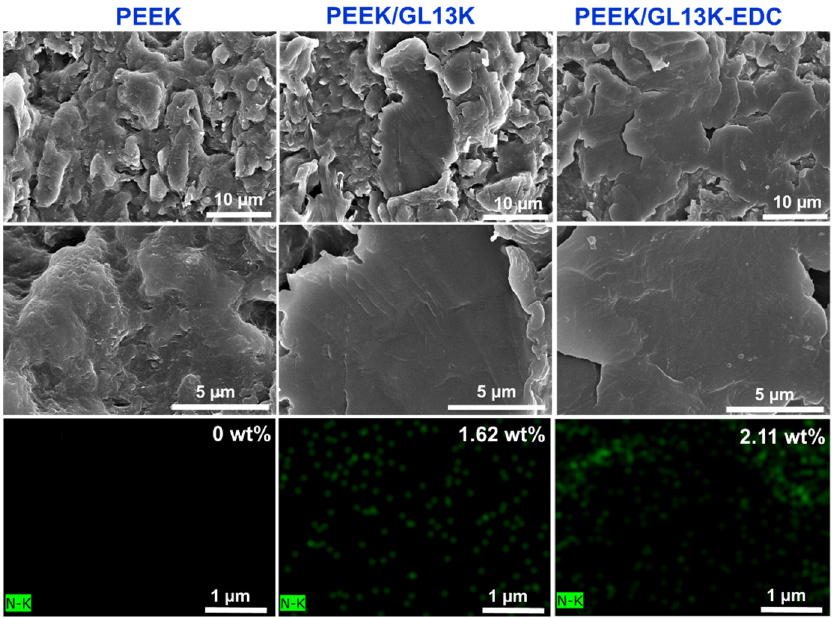
Figure 1. Field emission scanning electron microscopic (FESEM) images (top two rows) and nitrogen mapping from energy dispersive X-ray spectroscopy (EDX) micrographs (last row) of PEEK, PEEK/GL13K, and PEEK/GL13K-EDC samples.